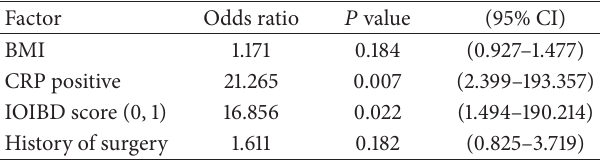
Table 4: Factors affecting the role of CE—multivariate